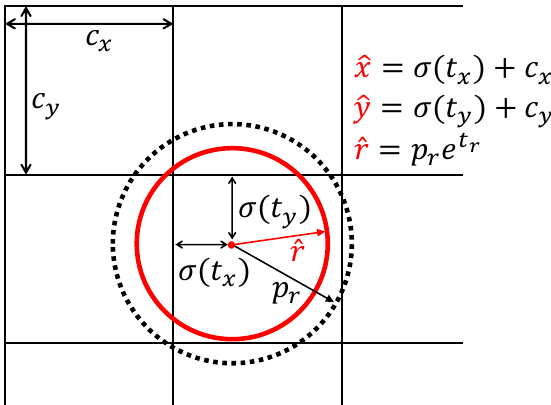
Figure 9. C-Bbox prediction. The black dotted circle indicates the prior anchor, and the red circle is the